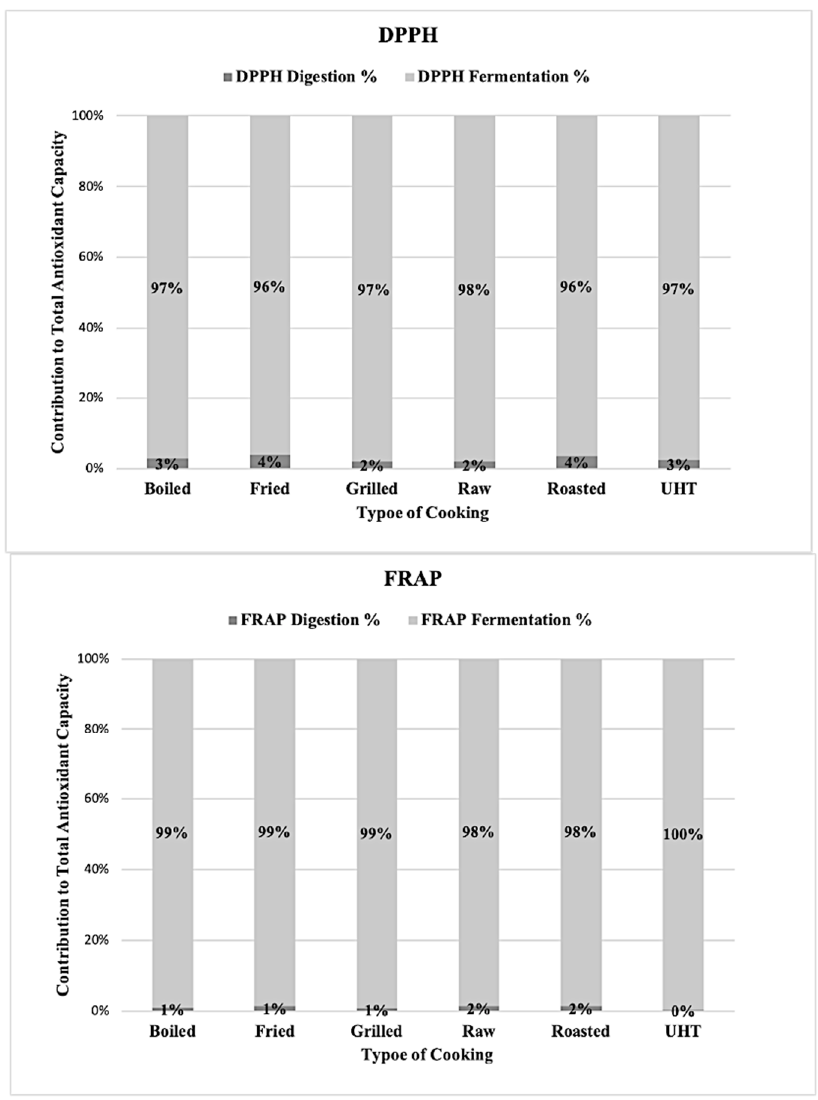
Figure 3. Contribution to the total antioxidant capacity of the fractions obtained after in vitro digestion depending of the cooking technique with the two antioxidant assays.